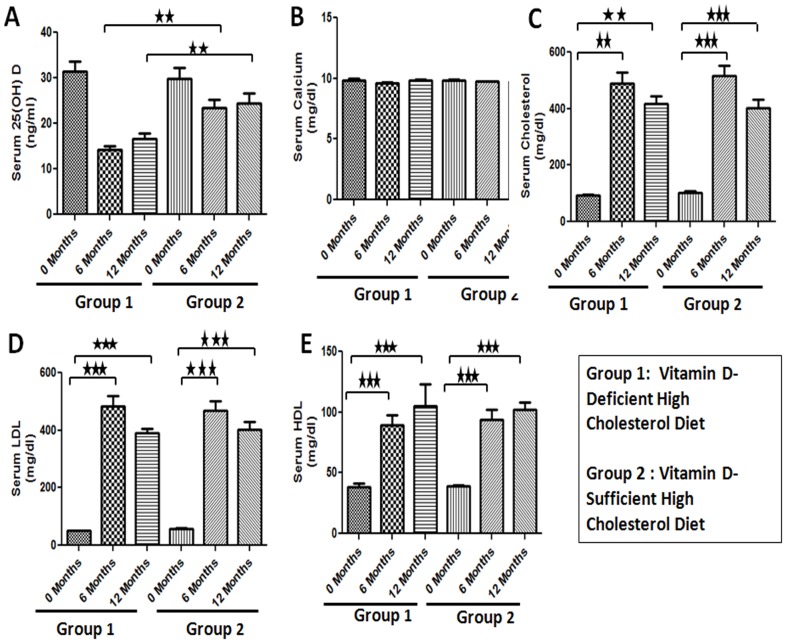
Effect of experimental diets on serum biochemical parameters in female Yucatan MiniSwine.Animals were fed vitamin D-deficient- or vitamin D-sufficient- high cholesterol diets and serum levels of 25-hydroxy vitamin D (A), calcium (B), total cholesterol (C), low density lipoprotein (LDL) (D), and high density lipoprotein (HDL) (E) were measured. Data are shown as mean ± SEM. (N = 8) **P<0.01, ***P<0.001.